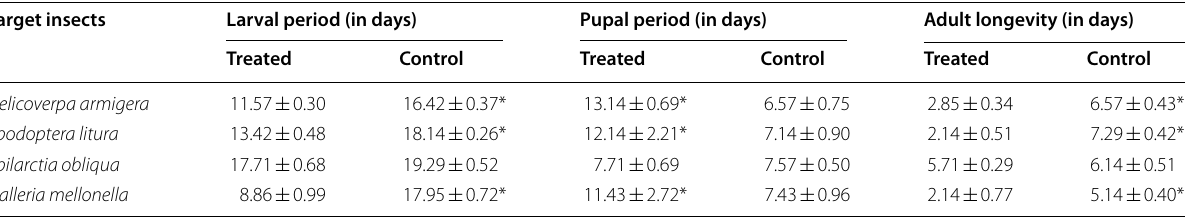
*Indicates the significant difference in number of days required to complete one instar, calculated by Student’s T test at 1% level of significance (mean presented in the table)